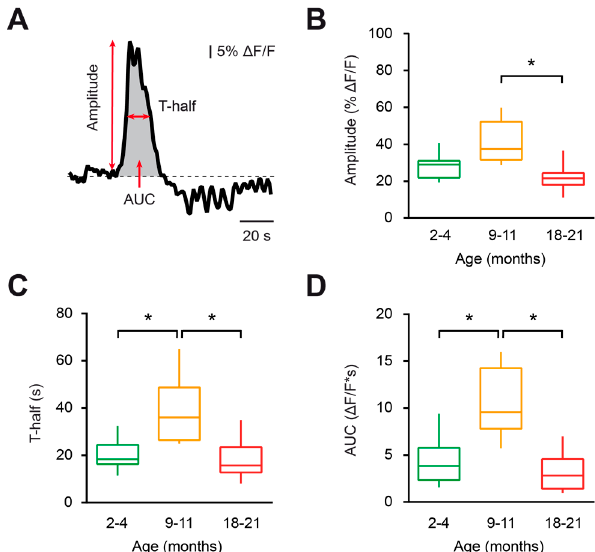
Figure 2. Characterization of spontaneous Ca 2+ transients in microglia during aging. ( A ) The schematic illustrates an example of a spontaneous Ca 2+ transient in microglia and the parameters of Ca 2+ transients analyzed in this study (amplitude, transient duration at half amplitude (T-half), and area under the curve (AUC)). ( B – D ) Box-and-whisker plots illustrating the median (per cell) amplitude ( B ), T-half ( C ), and AUC ( D ) of spontaneous Ca 2+ transients in microglial cells from 2–4- (green), 9–11- (orange) and 18–21- (red) month-old mice. Amplitudes, T-half and AUCs of Ca 2+ transients from 9–11-month-old mice were significantly higher compared to those of 18–21-month-old mice ( p < 0.01 for all comparisons, Kruskal–Wallis test). T-half and AUCs of Ca 2+ transients from 9–11-month-old mice were also significantly higher compared to those of 2–4-month-old mice ( p < 0.02 for both comparisons, Kruskal–Wallis test). However, the amplitudes of Ca 2+ transients in the latter two groups were similar ( p = 0.16, Kruskal–Wallis test). No significant differences were found between the 2–4- and 18–21-month-old mice ( p > 0.99 for all comparisons, Kruskal–Wallis test; n = 9, 9 and 16 cells from 2–4-, 9–11-, and 18–21-month-old mice, respectively). * p < 0.05 in ( B )–( D ).